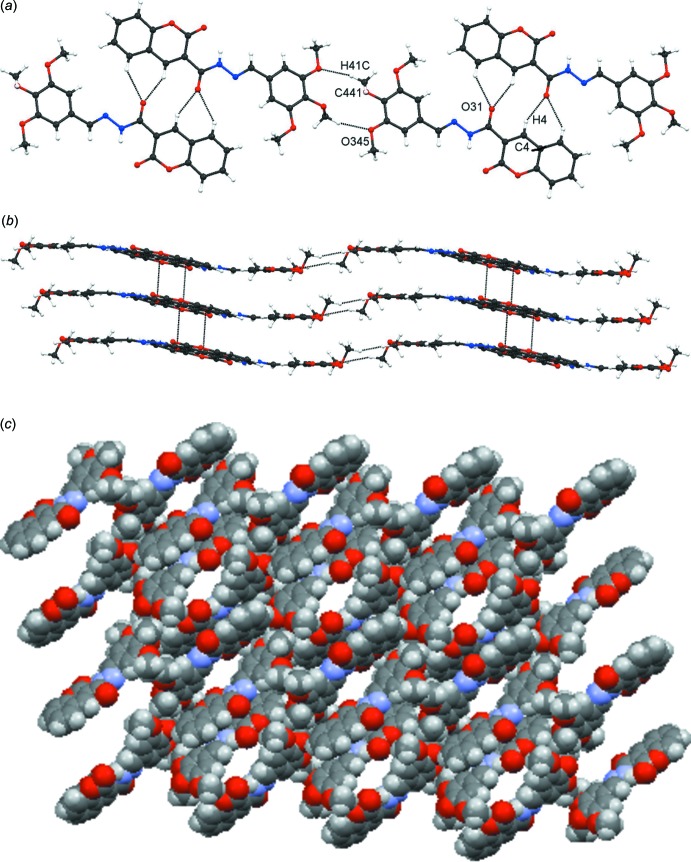
Compound [4: R = 3,4,5-(MeO)3C6H2·0.5DMSO]. (a) A two-mol­ecule-wide column of mol­ecules, formed from C4—H4⋯O31, C5—H5⋯O31 and C441—H41C⋯O345 hydrogen bonds, (b) columns linked into undulating sheets by C31=O31⋯π(1) inter­actions and (c) a spiral of mol­ecules, which creates a channel into which the disordered solvate mol­ecules are held by a number of C—H⋯X (X = O, N or S) hydrogen bonds: the channel is generated from C431–H43B⋯π(3), C451—H51B⋯π(3) and C451—H51C⋯π(2) inter­actions and lies along the crystallographic twofold axis.